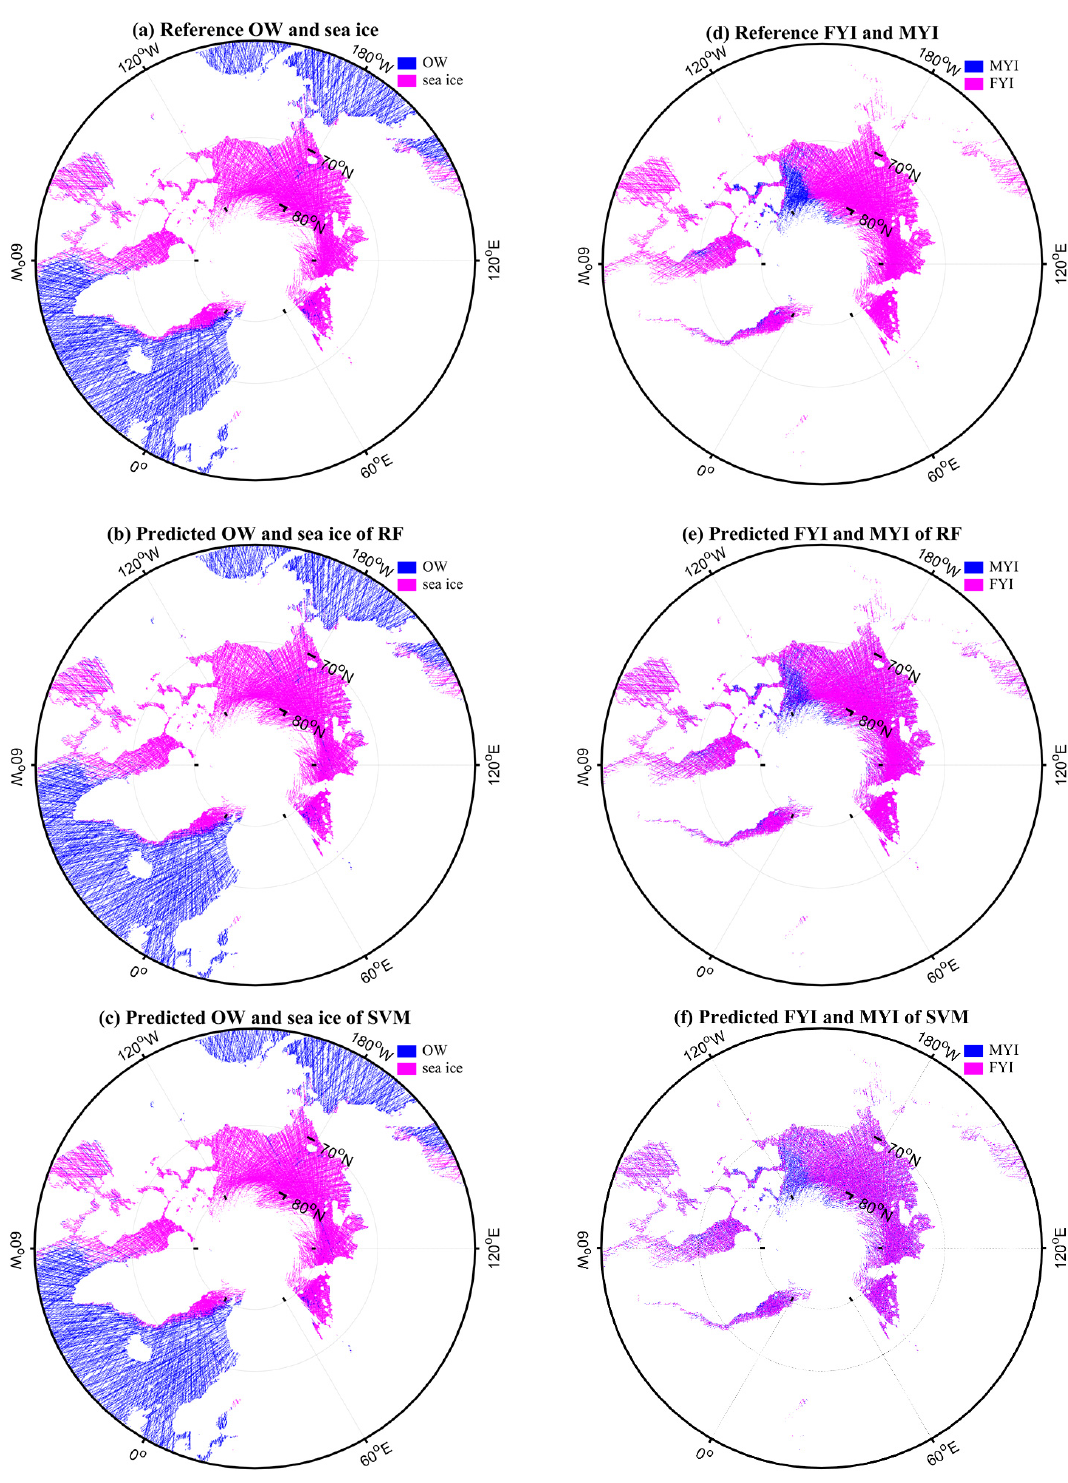
Figure 12. Classification results of random forest (RF) and support vector machine (SVM) classifiers. ( a ) Reference open water (OW) and sea ice. ( b ) Predicted OW and sea ice of RF. ( c ) Predicted OW and sea ice of SVM. ( d ) Reference first-year ice (FYI) and multi-year ice (MYI). ( e ) Predicted FYI and MYI of RF. ( f ) Predicted FYI and MYI of SVM.